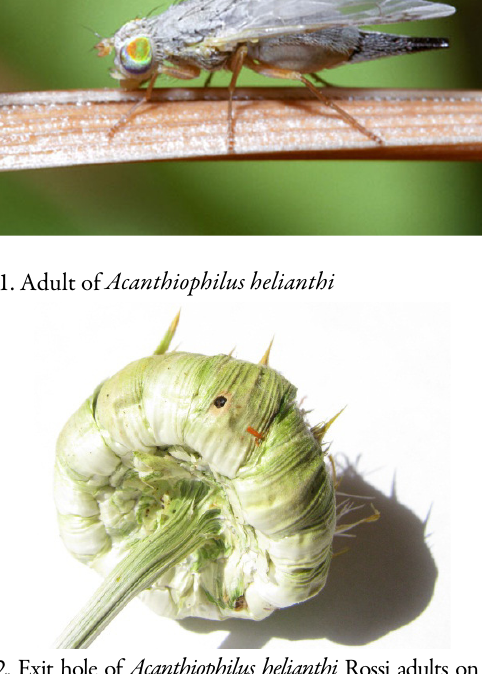
Fig. 12. Exit hole of Acanthiophilus helianthi Rossi adults on flower head of